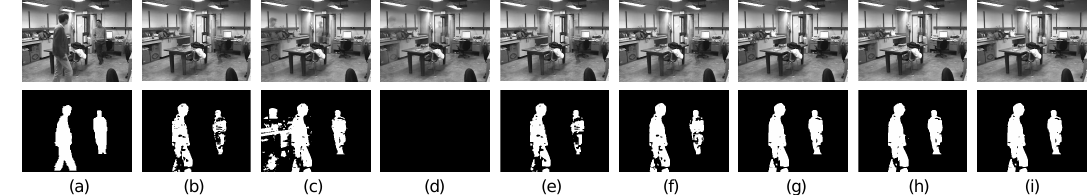
Figure 7. Background modeling results on the Li data set. ( a ) One frame of the original video Y (top) and the ground truth (bottom). Low-rank component X (top) and sparse component E (bottom) obtained by RPCA ( b ), LR-MDL ( c ), CoGEnT ( d ), BSGFL ( e ) PSSV ( f ), ROUTE ( g ), FGSR ( h ) and the proposed approach ( i ).